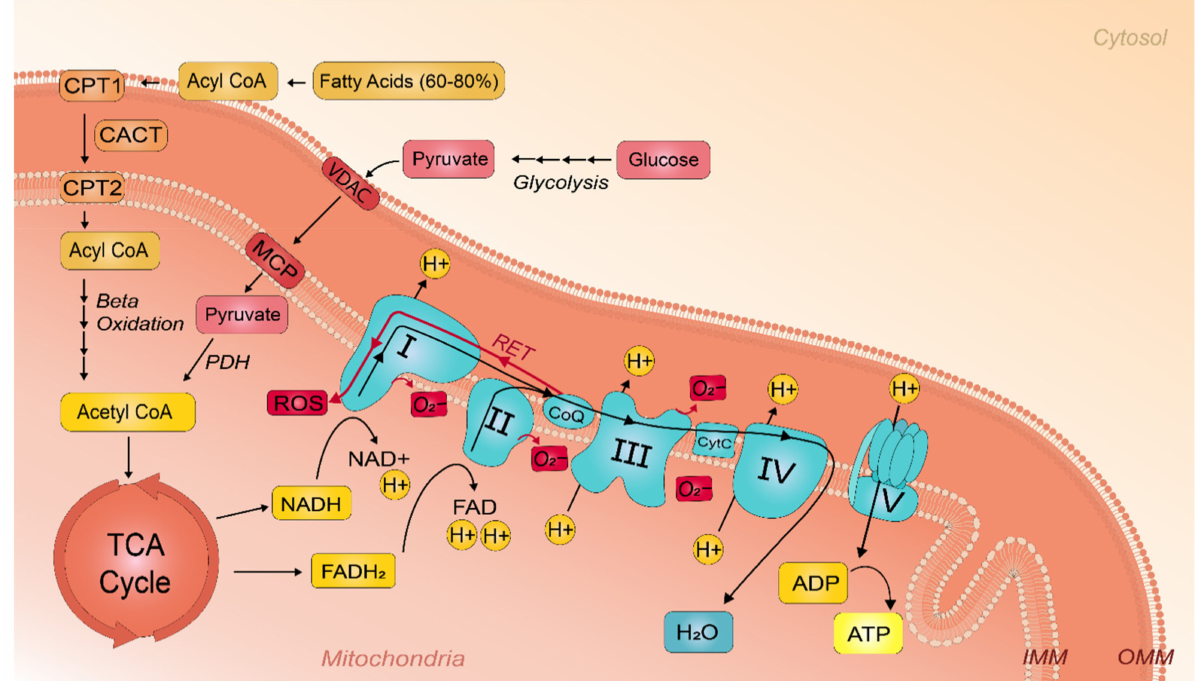
Figure 1. Schematic representation of ATP generation via fatty acid and glucose oxidation and leakage of reactive oxygen species in the mitochondria. Mitochondrial oxidative phosphorylation at the ETC is driven by the substrates NADH and FADH 2 , which originate predominantly from FA and carbohydrate oxidation. FAs pass the mitochondrial membrane as acyl-CoA by means of the carnitine acyltransferase membrane shuttles, consisting of CPT-1, CPT-2, and CACT. CPT1 converts acyl-CoA to acylcarnitine, which is subsequently transferred across the IMM by CACT. Inside the mitochondria, acylcarnitine is converted back into acyl-CoA by CPT-2. During β -oxidation, 2-carbon units are oxidized to produce acetyl-CoA, which is the substrate for the TCA cycle. Pyruvate traverses the mitochondrial membranes through VDAC and MPC. Once inside the mitochondrial matrix, pyruvate gets oxidized into acetyl-CoA to enter the TCA cycle. The reducing agents NADH and FADH 2 are produced inside the TCA cycle. Electrons from NADH and FADH 2 are donated to the complexes of the ETC, which translocate protons into the intermembrane space to establish a proton gradient for ATP synthesis. ROS are formed as by-products of the ETC. Not all of the electrons are transferred to the final electron acceptor as some leak out of the ETC into the mitochondrial matrix, followed by superoxide production. ROS overproduction contributes to oxidative stress and mitochondrial